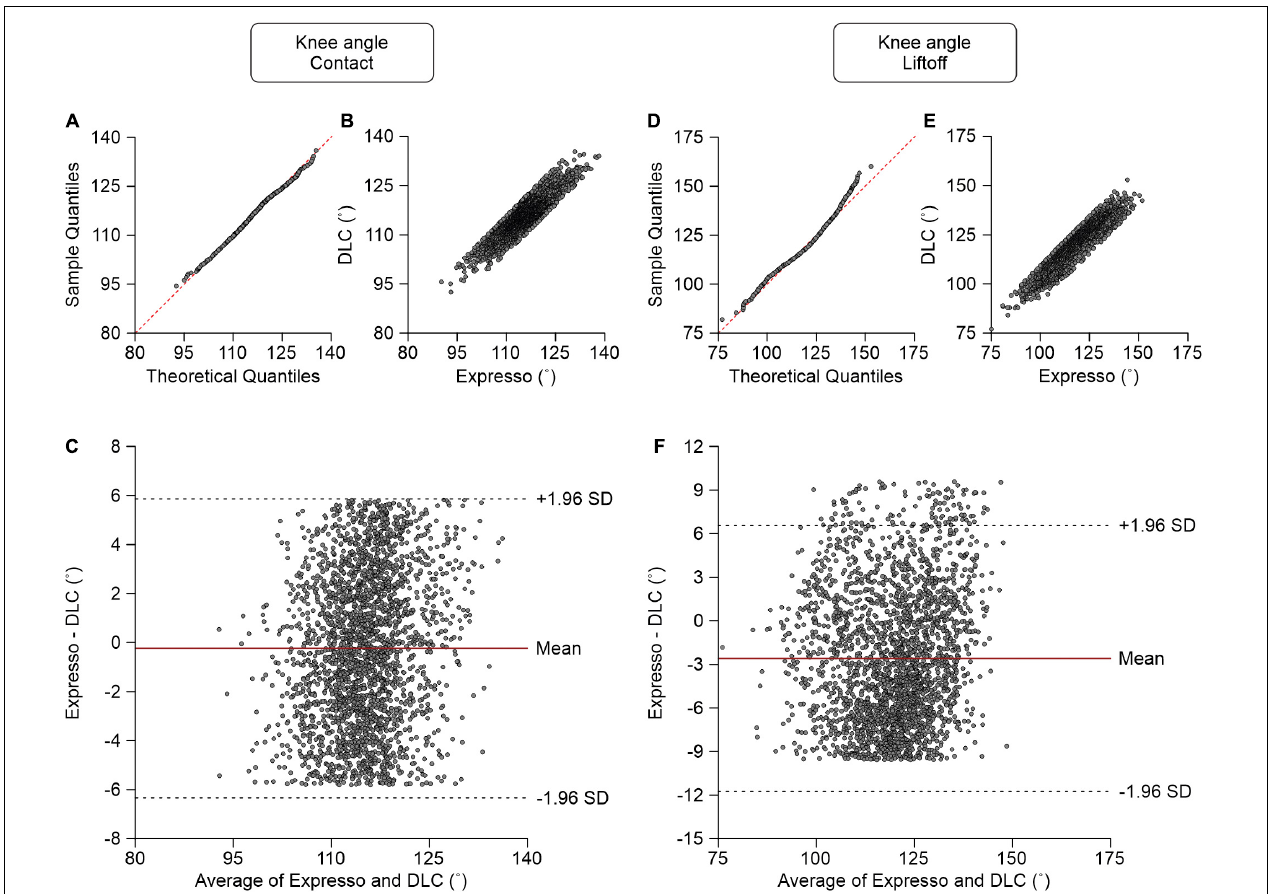
FIGURE 6 | Comparison of knee joint angles at contact and at liftoff measured with data from Expresso and DLC. (A) Knee angle at contact QQ-plot where the red dashed line represents a perfect normal distribution. (B) Knee angle at contact scatter plot of values obtained with Expresso and DLC. (C) Bland–Altman plot of knee angle at contact measurements from Expresso and DLC. The solid red line is the mean difference between the two methods and black dashed lines show ± 1.96 standard deviations. (D) Knee angle at liftoff QQ-plot where the red dashed line represents a perfect normal distribution. (E) Knee angle at liftoff scatter plot of values obtained with Expresso and DLC. (F) Bland–Altman plot of knee angle at liftoff measurements from Expresso and DLC. The solid red line is the mean difference between two methods and black dashed lines show ± 1.96 standard